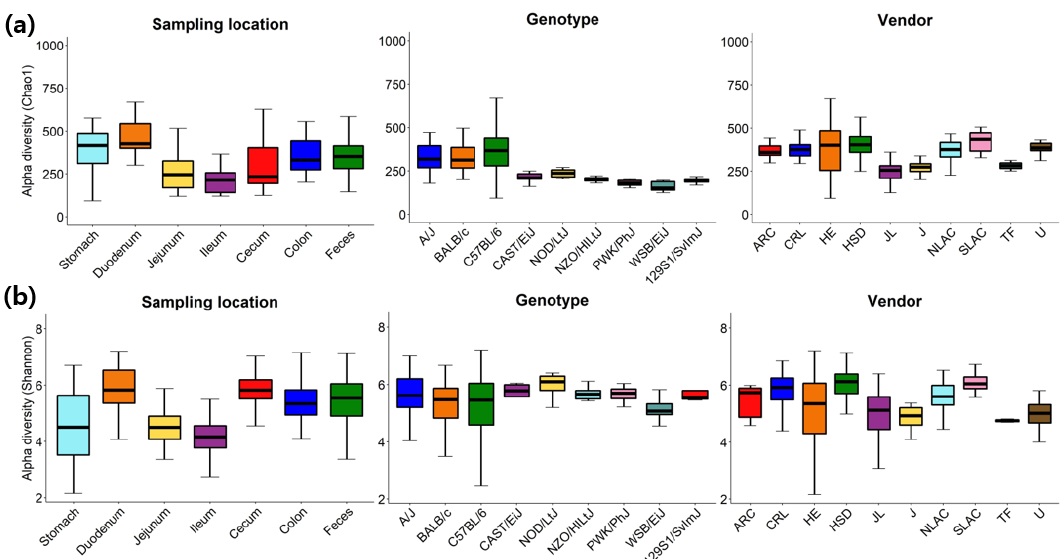
Figure 2. Alpha diversity of samples grouped by sampling locations, genotypes or vendors as measured using ( a ) Chao1 and ( b ) Shannon with the rarefied number of reads (10,175 reads per sample). ARC, Animal Resource Centre; CRL, Charles River Laboratories; HE, Harlan Envigo; HSD, Harlan Sprague Dawley; JL, Jackson Laboratory; J, Janvier; NLAC, National Laboratory Animal Center; SLAC, Shanghai Laboratory Animal Center; TF, Taconic farms; U, UAMS.